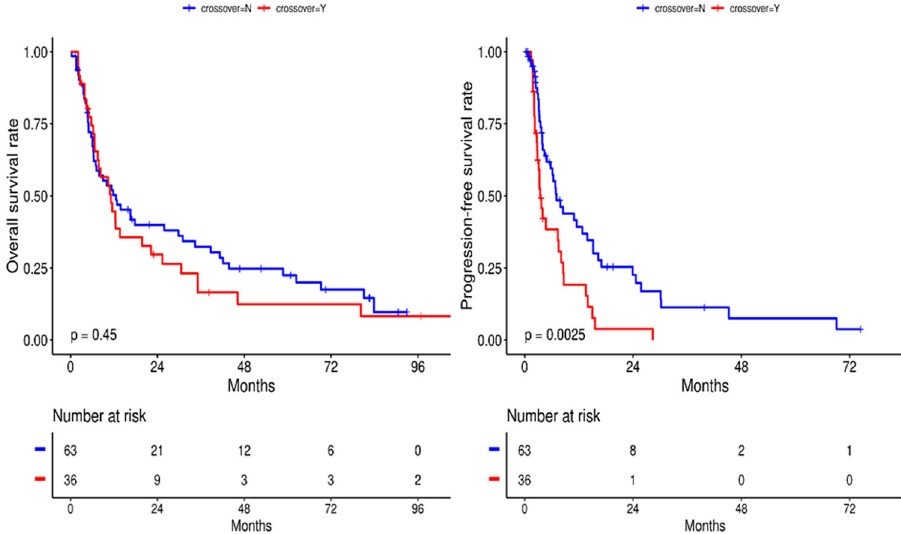
Fig. 4 Survival outcomes based on BRAF V600E and non-V600E mutations. No statistical signi fi cance was seen between both groups, although the median OS was higher in the V600E group at 12.3 months compared to 4.8 months in the non-V600E group and median PFS was 6.8 months in the V600 group and 3.5 months in the non-V600E